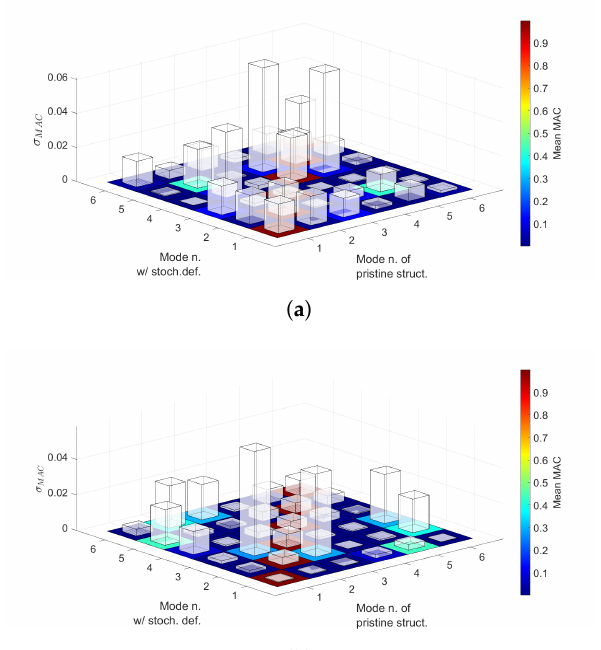
Figure 18. ( a ) Case 1 3D MAC matrix, ( b ) Case 2 3D MAC matrix. Floor indicates the mean value and bars the standard deviation of each component of the matrix. Fibre volume fraction is treated as a Gaussian random variable with mean value V f = 0.60 and standard deviation σ V misalignments have a null mean and standard deviation σ θ = 1.5 ◦